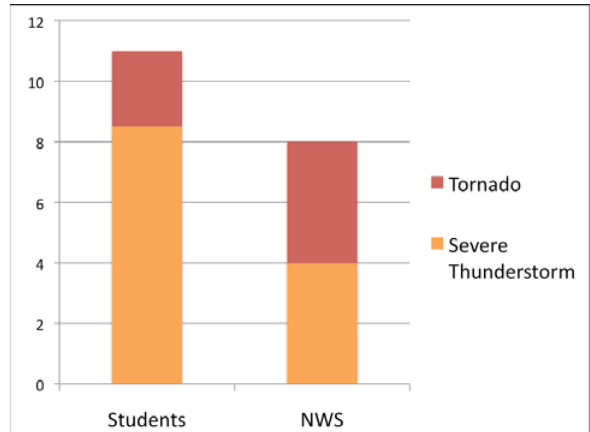
Figure 2. Average number of warnings issued by student groups compared to the number issued by the National Weather Service from 2100 to 2240 UTC on 11 April. Tornado warnings are indicated in red, while severe thunderstorm warnings are shown in